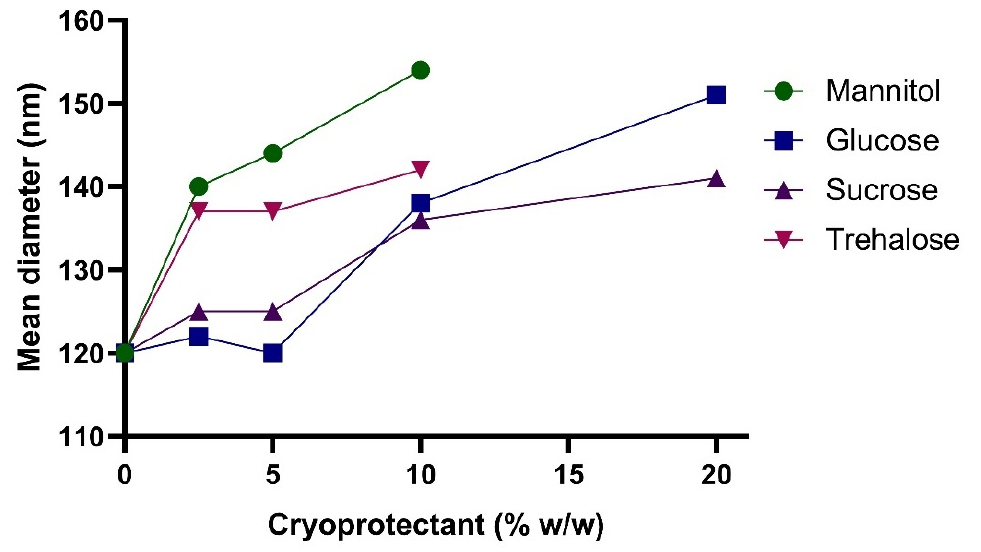
Figure 3. PLGA 75:25 nanoparticle mean hydrodynamic diameter as a function of the percentage of the different cryoprotectants when added before pouring the acetone solution into the aqueous phase ( n = 3, S.D. < 10% for all samples).